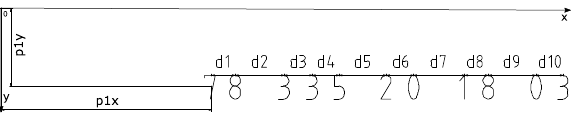
Figure 2. Location of the leftmost digit ( p 1 = p 1 x , p 1 y ) and the distances d 1, ... d 10 between the digits in the display.